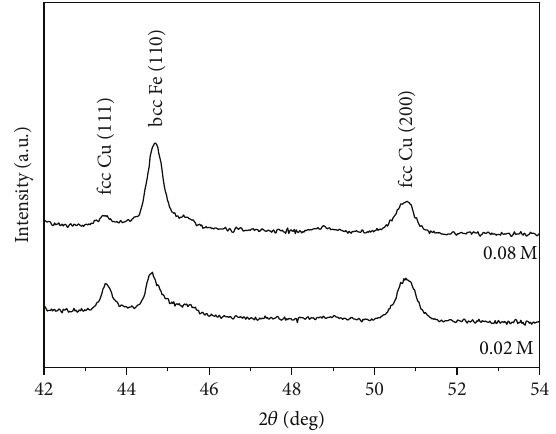
Figure 2: XRD patterns of electrodeposited Fe–Cu films prepared from the electrolytes with low and high Fe ion